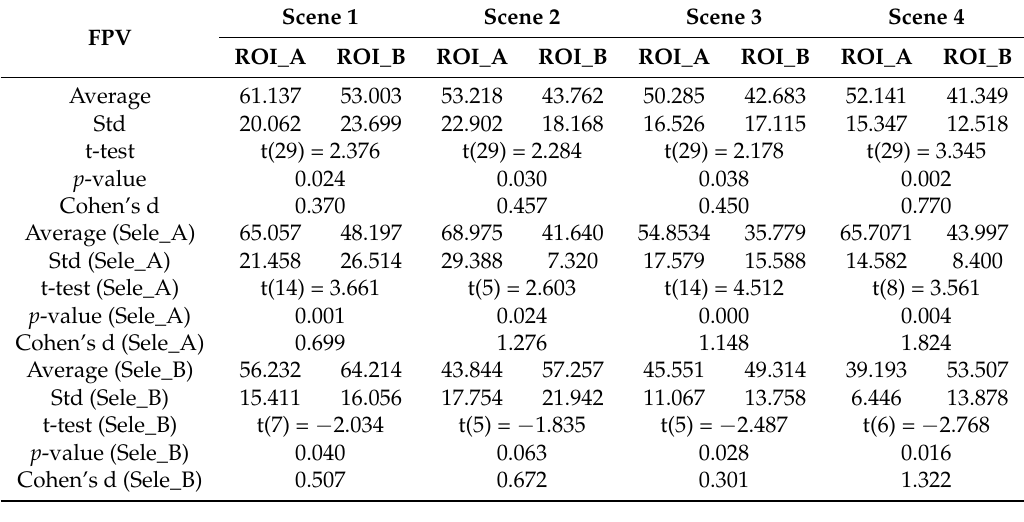
Table 2. Statistical analysis of fixation-point variance (FPV) for four scenes in both tests.